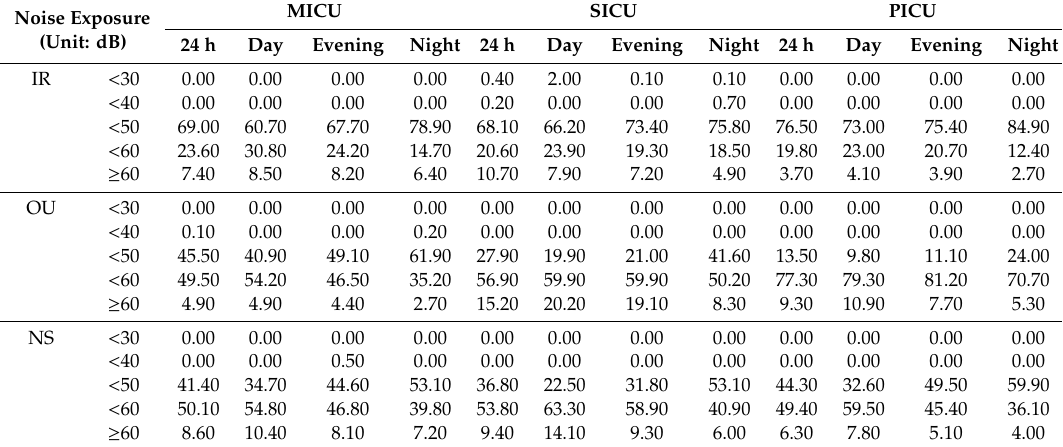
Table 2. Noise exposure level distribution seconds (%) according to each ICU and time schedule. Noise Exposure (Unit: